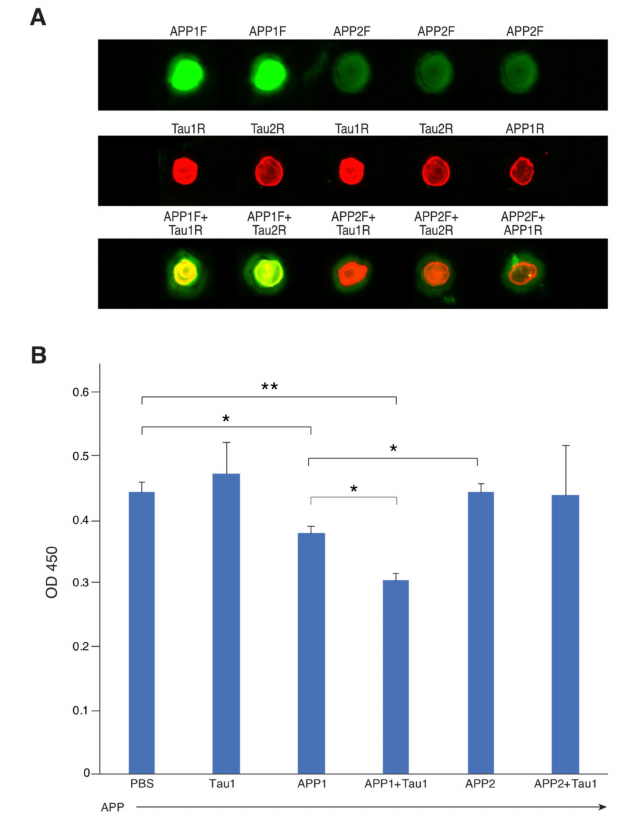
Figure 2. Confirmation of APP and Tau peptide binding by visualization and ELISA. ( A ) Visualization of APP and Tau peptide binding labelled by fluorescein (F) or rhodamine (R). Single labelled peptides were loaded on nitrocellulose membrane [upper row (F) and middle row (R)]. Mixtures were loaded (lower row) from left to right: APP1F + Tau1R, APP1F + Tau2R, APP2F + Tau1R and APP2F + Tau2R. Last sample was a control of APP2F + APP1R. As can be seen the only two peptides that bound to each other were APP1F and Tau1R as the color mix combination of green and red resulted in yellow (except for a faint yellow color for the combination of APP1F +